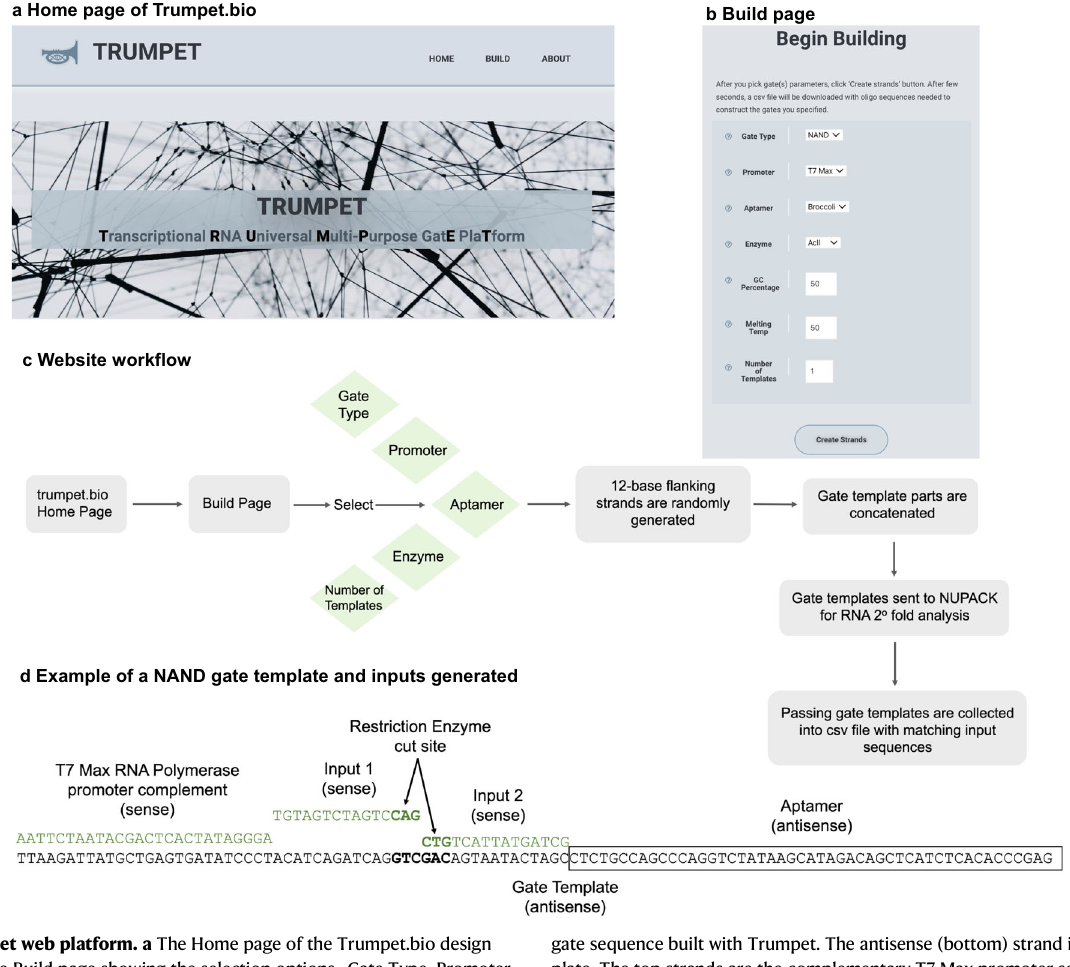
gate sequence built with Trumpet. The antisense (bottom) strand is the gate tem- plate. The top strands are the complementary T7 Max promoter sequence or the gate